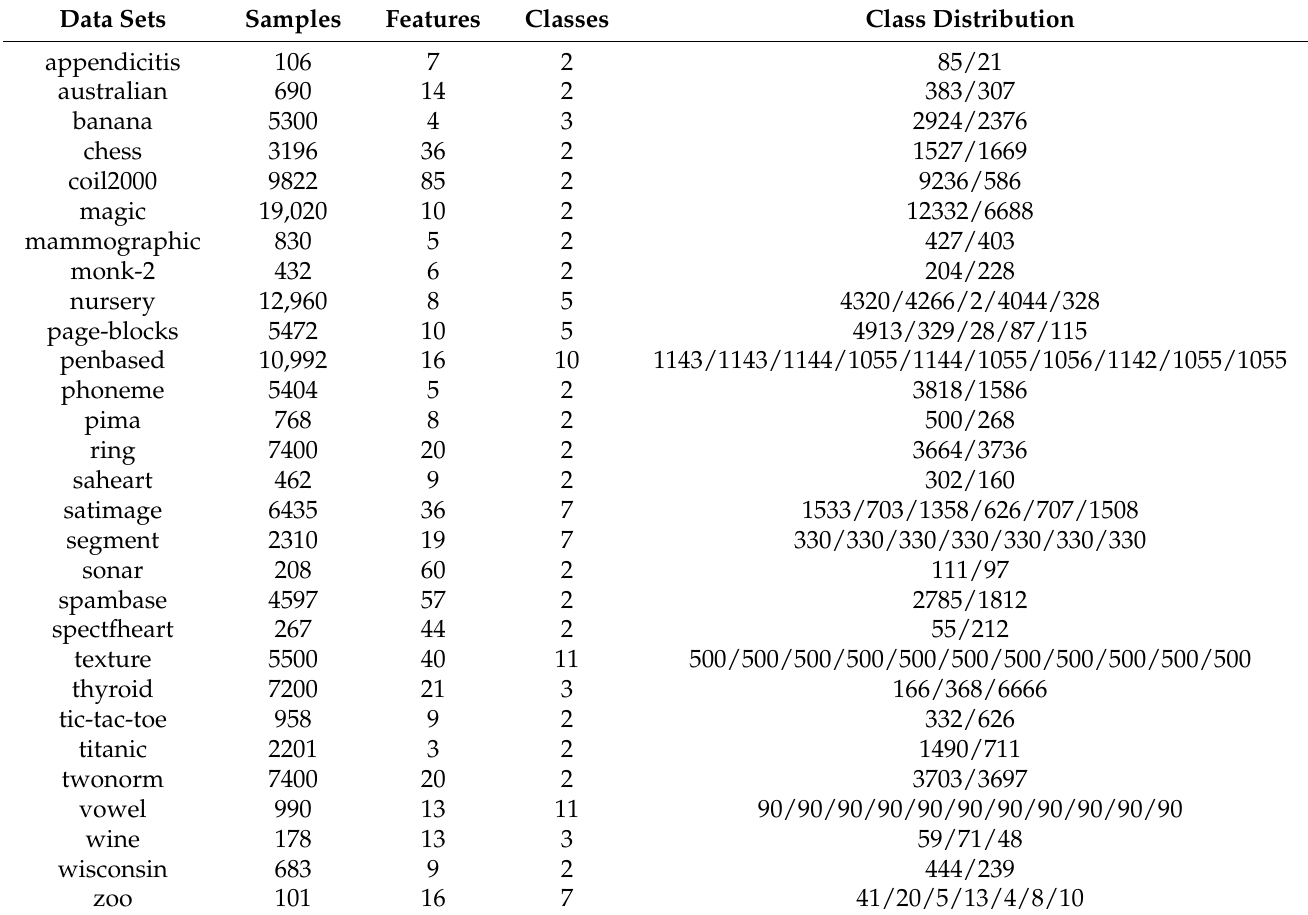
Table 2. Descriptions of the 29 benchmark data